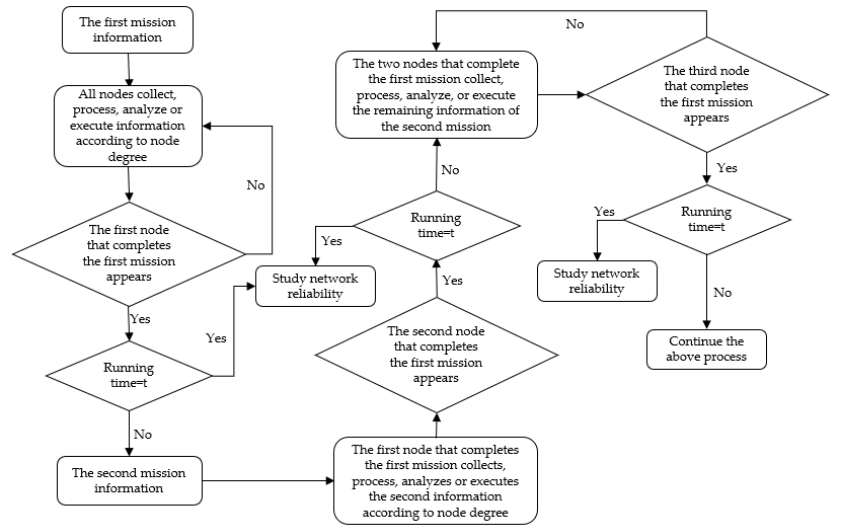
Figure 3. Information collection, processing, execution or response process of multiple missions.